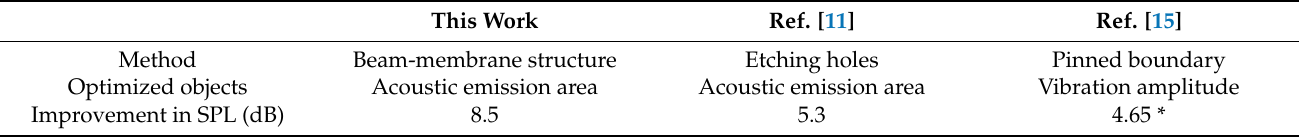
Figure 4. ( a ) Simulated mode shape of the T-PMUT with different radii. ( b ) Simulated far-field SPL of BM-PMUT and T-PMUT. Table 2. Comparison with previous works.